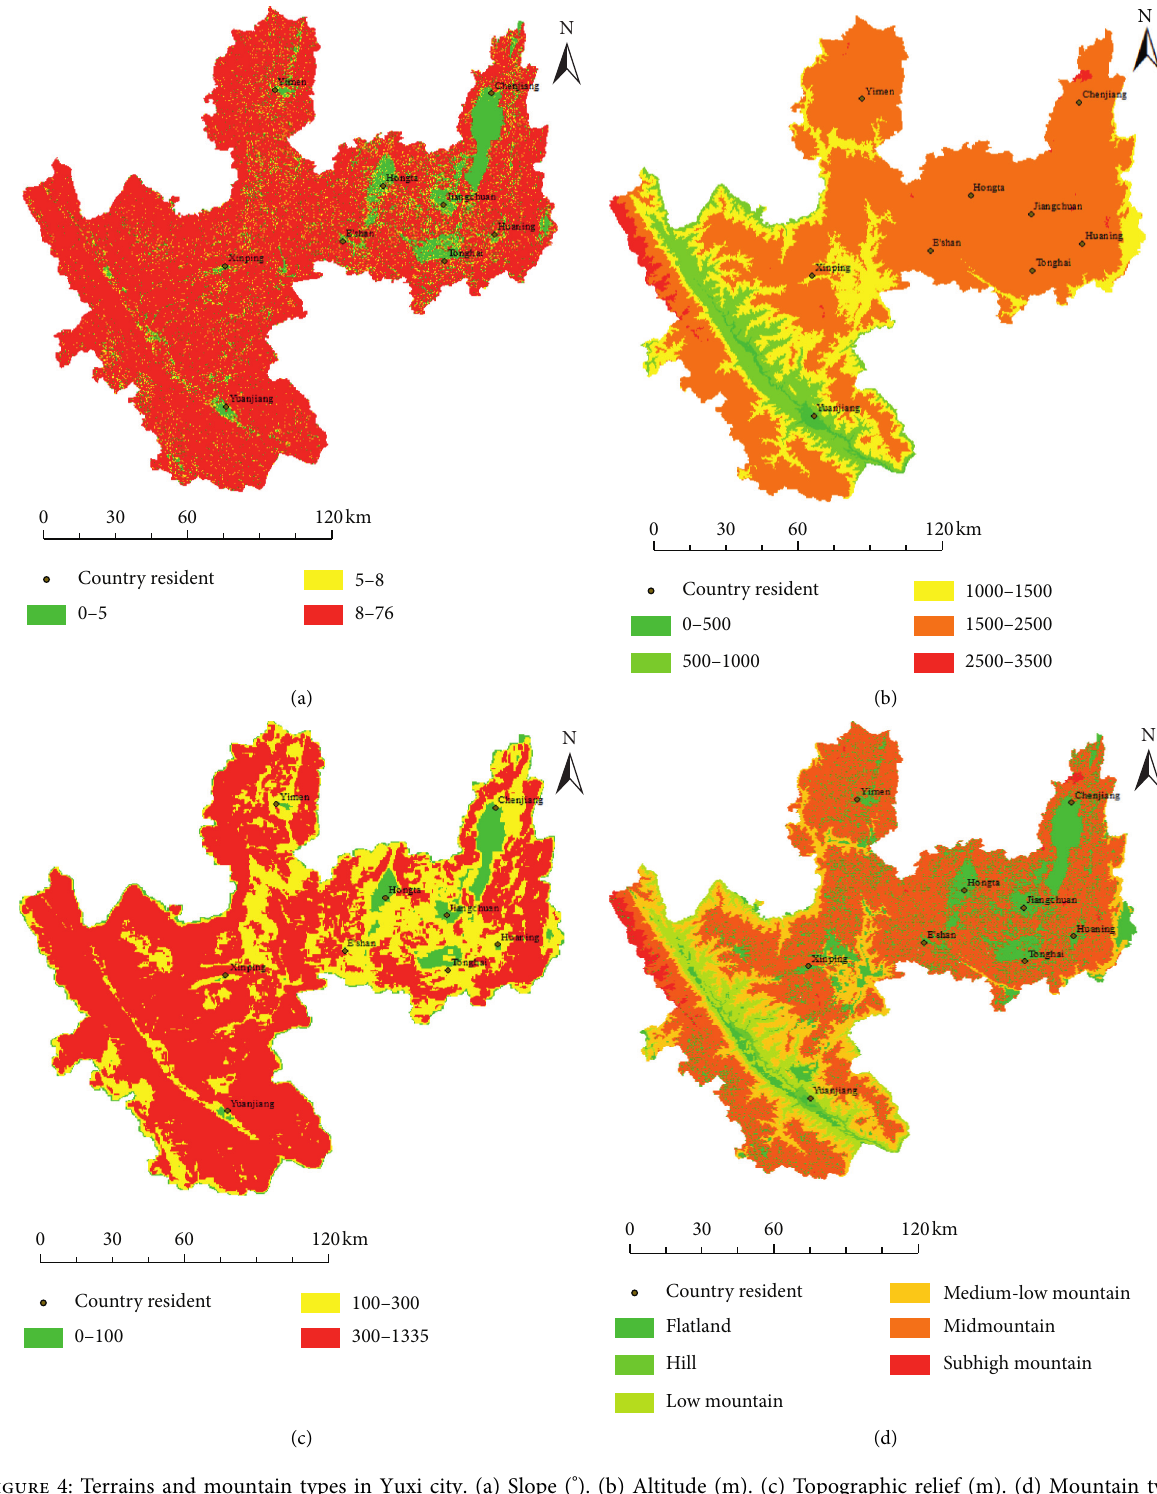
Figure 4: Terrains and mountain types in Yuxi city. (a) Slope ( ° ). (b) Altitude (m). (c) Topographic relief (m). (d) Mountain